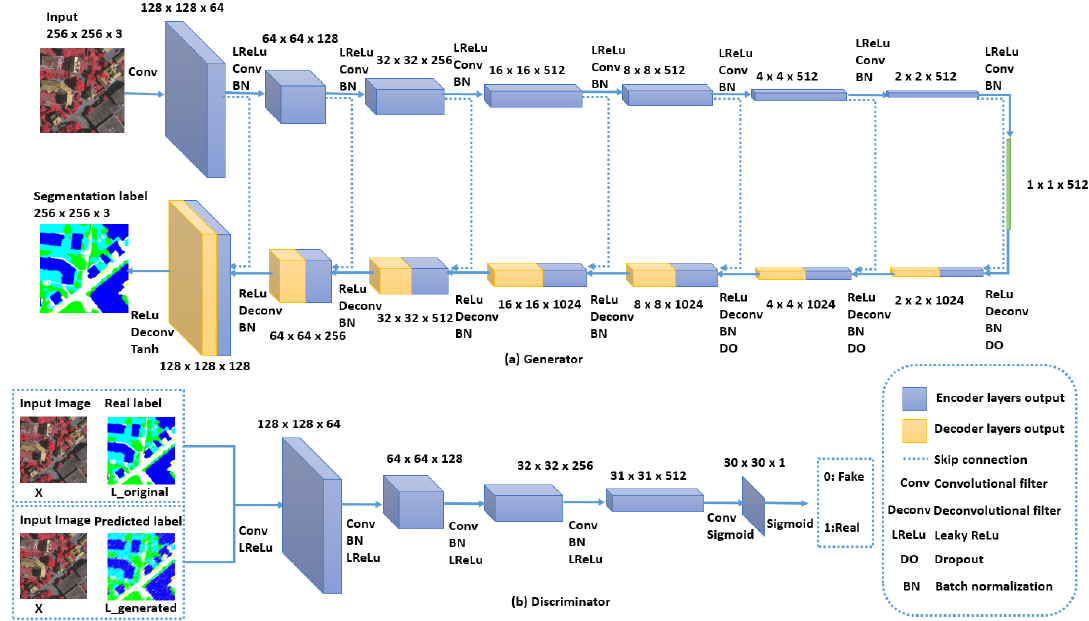
Figure 4. The architecture of the first GAN network: ( a ) the generator and ( b ) the discriminator. Concerning the discriminator, it takes as input pairs of images from two sets. The first set is images from the target dataset associated with their real label ( X target , L original ) . Data from this set should